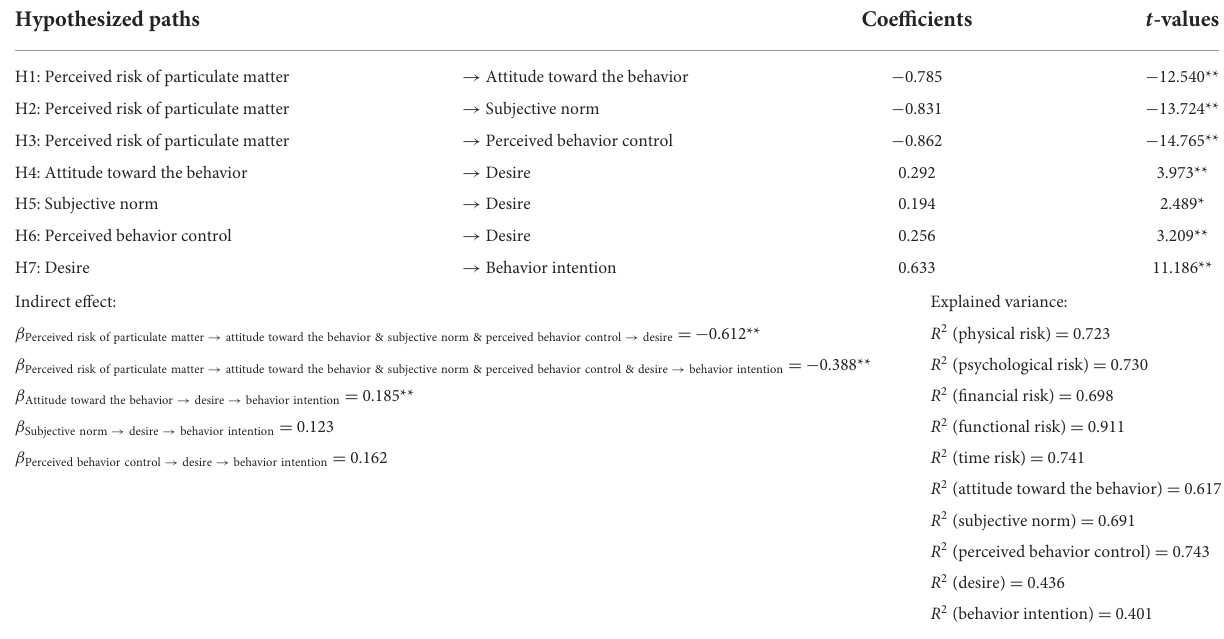
TABLE 2 Structural equation